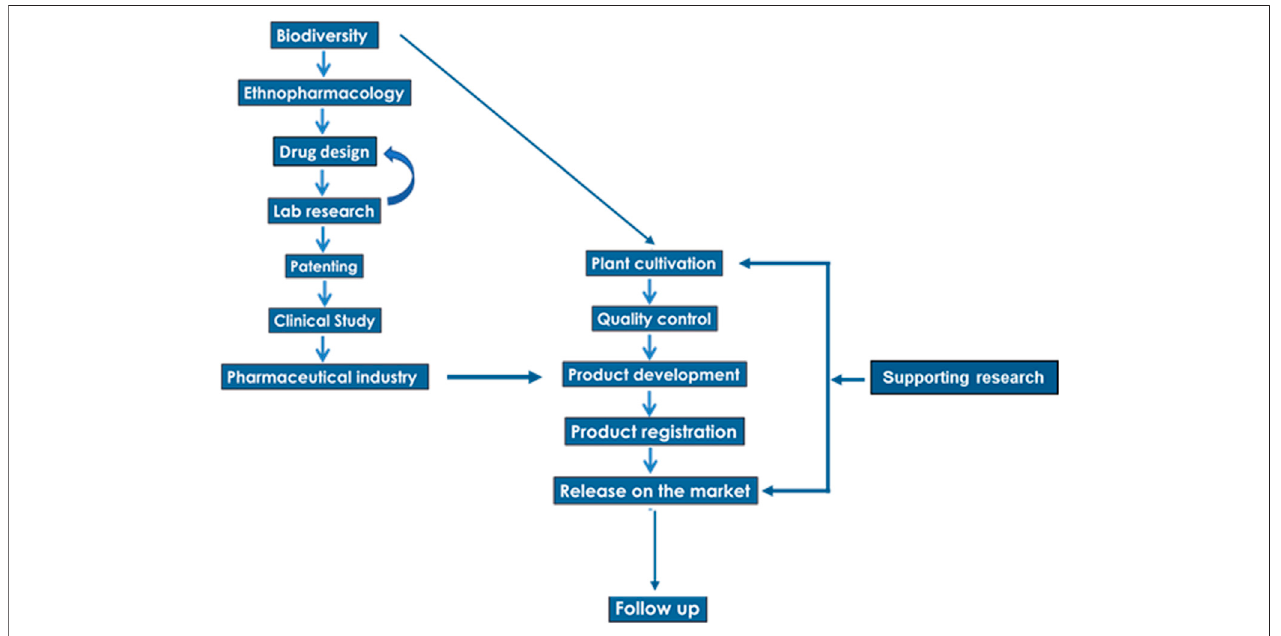
FIGURE 3 | The fl ow-chart of a translational chain